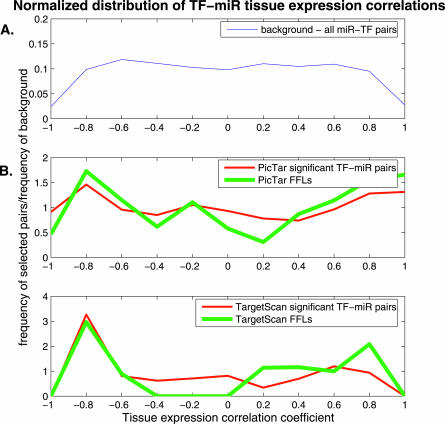
Tissue Expression Correlations between miRs and TFsmiR tissue expression in brain, liver, thymus, testes, and placenta were taken from [34]. mRNA tissue expression was taken from [35].(A) Background distribution of all possible miR–TF pairs for which expression profiles can be derived.(B,C) Normalized histograms of correlation coefficients; the same distribution as in (A) was made, yet only for significantly co-occurring miR-TF pairs (red), and FFLs (green) in the PicTar (B) and TargetScan (C) networks. The figure shows the proportion of the various correlation coefficients divided by the background distribution depicted in (A).